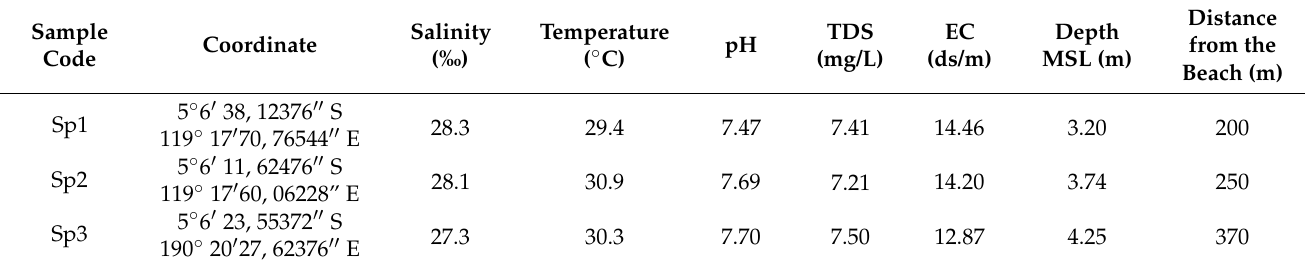
Table 1. Characteristics of seawater at sampling points for sponges around Kodingareng Keke Island.